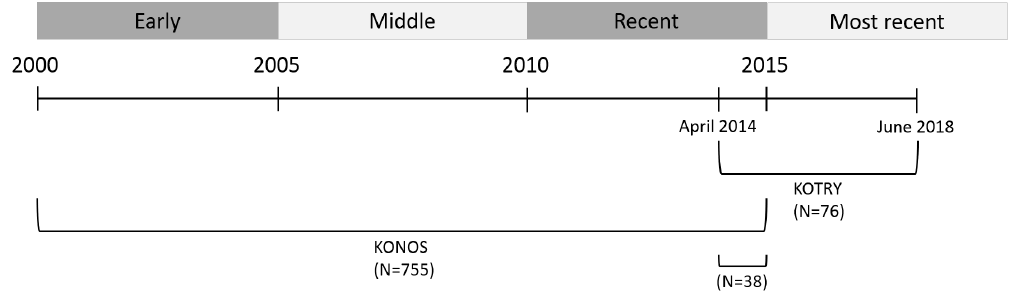
Figure 1. Schematic graph showing chronological difference between the Korean Network Organ Sharing (KONOS) and Korean Organ Transplantation Registry (KOTRY) databases.